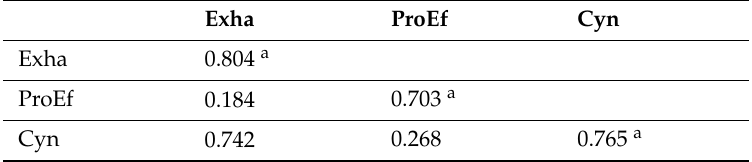
Note: a Root square of